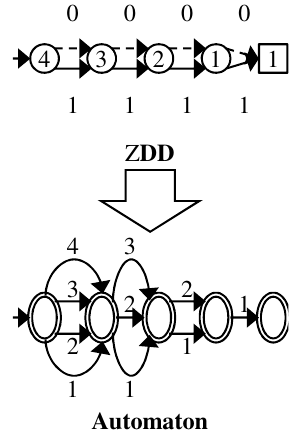
Figure 4. Worst-case example of a straightforward